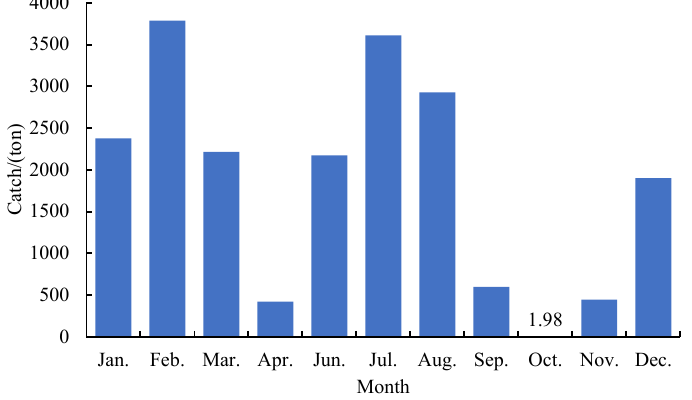
Figure 1. Monthly catch of squid-jigging vessels in the equatorial waters of Eastern Pacific. Marine environmental data including SST, SSS, SSH, PAR, and Chl_a were also col- lected for use in this paper. SSS was obtained from the Hawaii Asia-Pacific Data Cen- tre with a temporal resolution of one month (0.5 ◦ resolution) accessed on 9 July 2022 (http://apdrc.soest.hawaii.edu/). SST, SSH, and Chl_a were obtained from the Copernicus Ocean Service network with a temporal resolution of one month (0.25 ◦ resolution) on 9 July 2022 (https://resources.marine.copernicus.eu/products). PAR was obtained